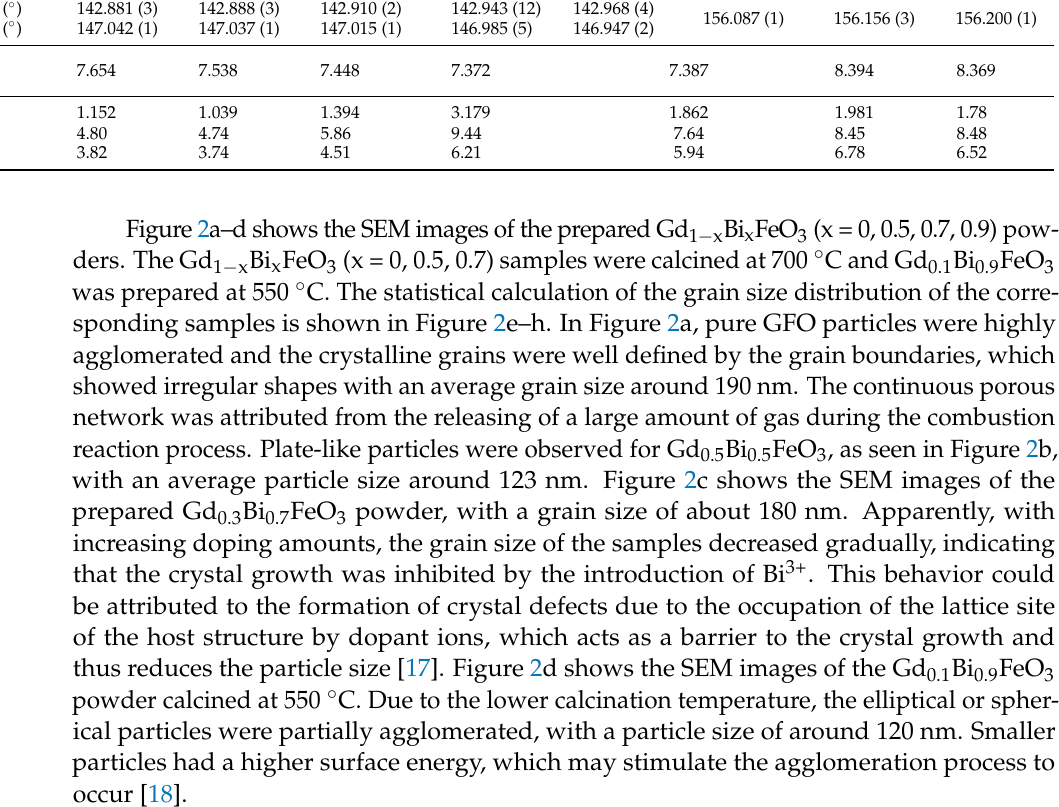
Table 1. Refined structural parameters for Gd 1